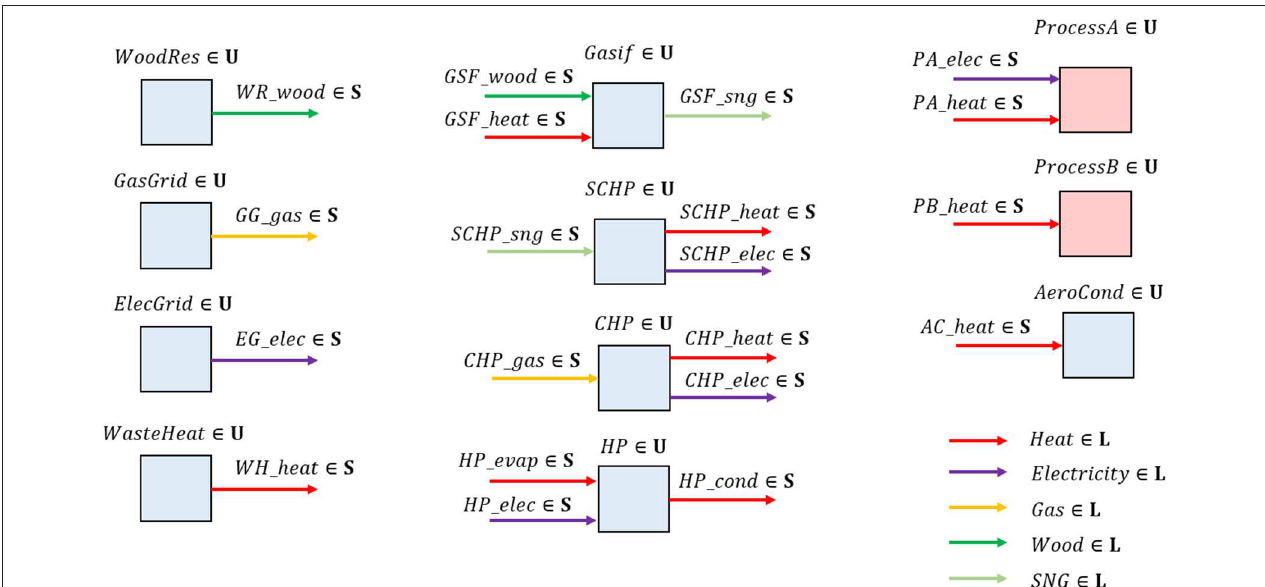
FIGURE 2 | Illustrative example showing the main sets of the MILP